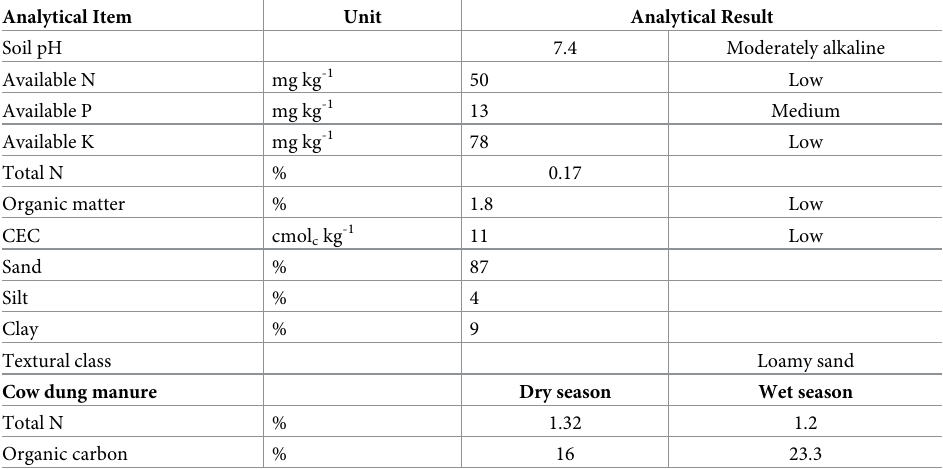
Table 2. Physiochemical properties of experimental soil and cow dung manure used in the second pot